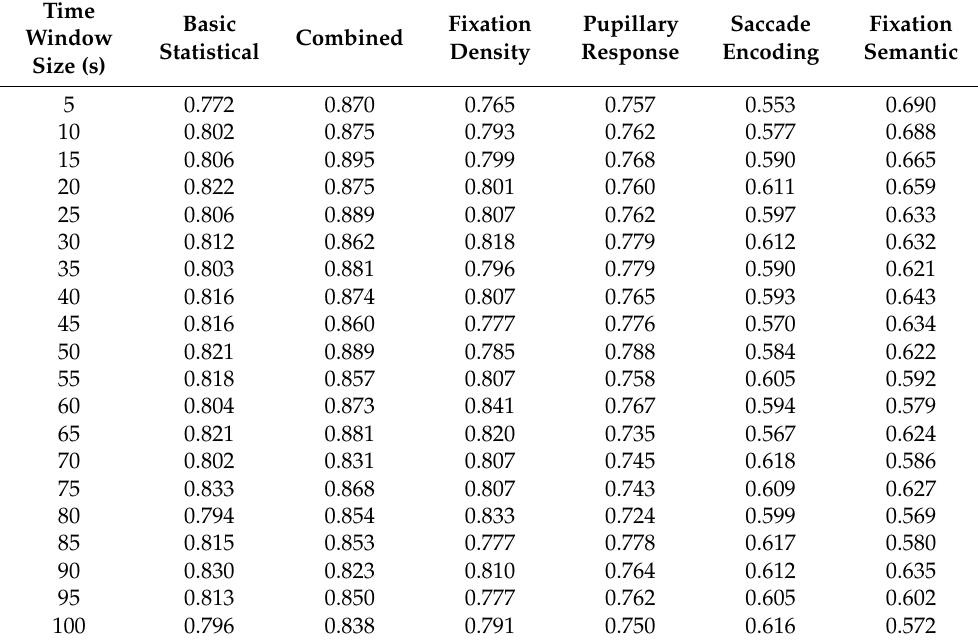
Table A3. Mean accuracy of the verification